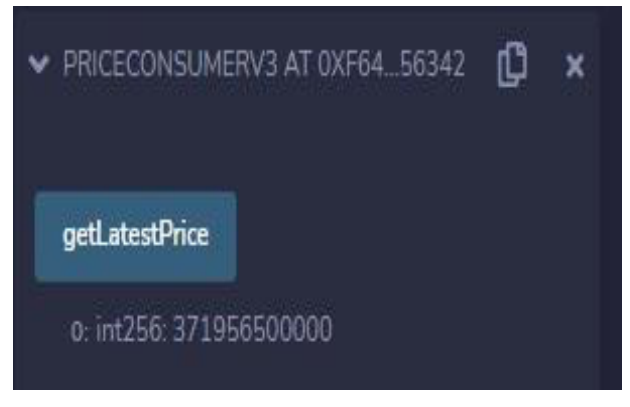
Fig. 3. Latest price function call